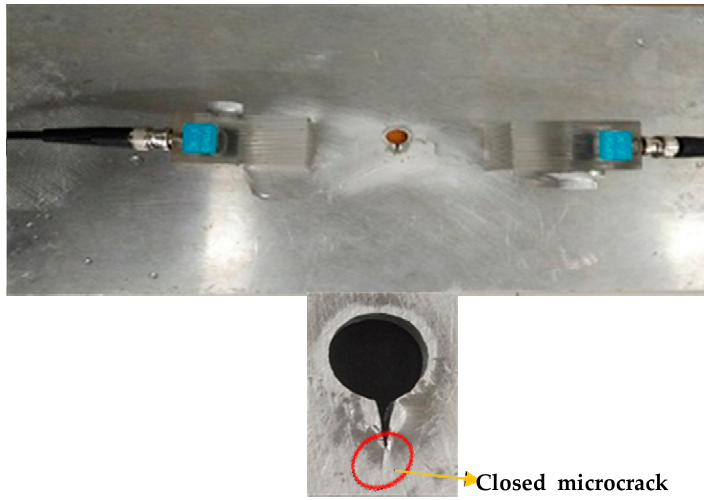
Figure 15. Physical map of crack.